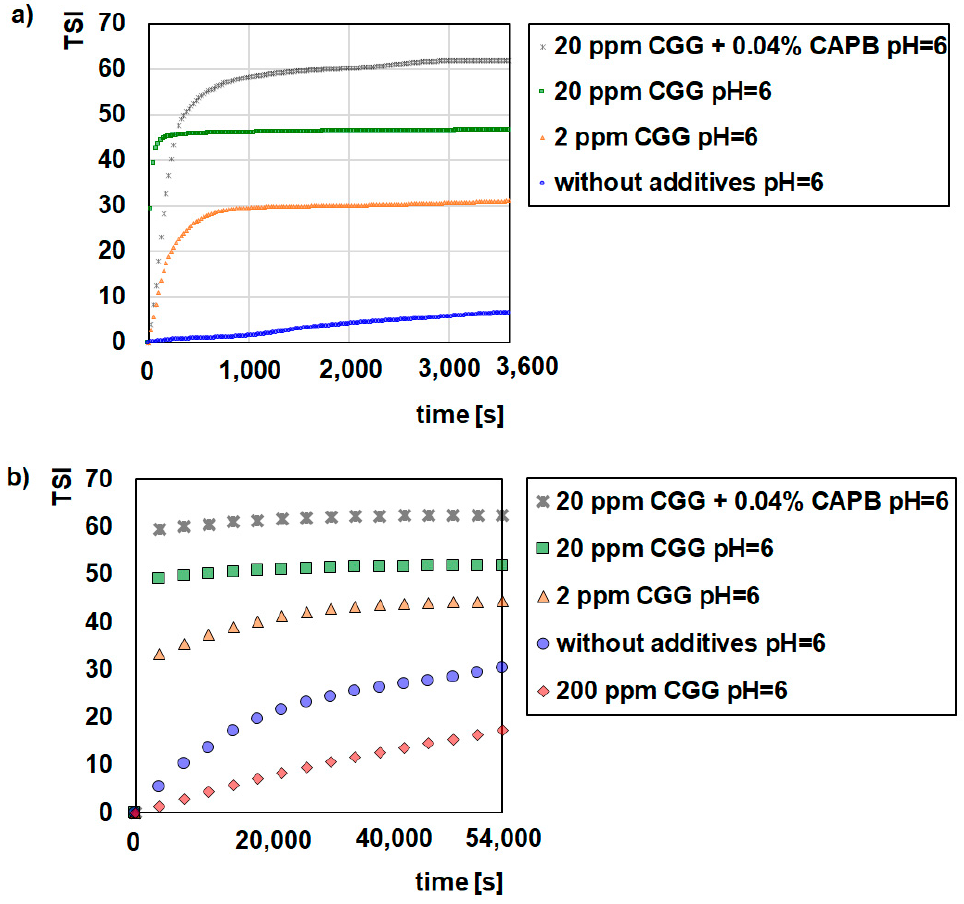
Figure 2. Influence of CGG with the addition of 0.04% CAPB on stability of the glauconite suspensions at pH = 6; 1 h ( a ), 15 h ( b ).